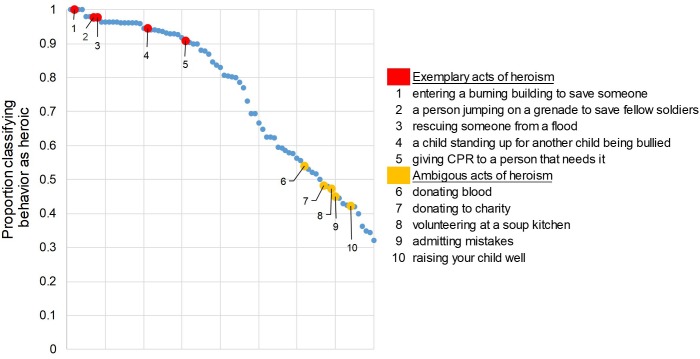
Candidate acts of heroism generated by subjects were broadly (examples in red) or ambiguously (examples in yellow) considered heroic by a separate sample. Shown is a scatterplot of the proportion of subjects rating each of 80 candidate behaviors as “Heroic” (1) or “Not heroic” (0) ranked from most to least heroic. (X-axis represents dummy values for act of heroism).